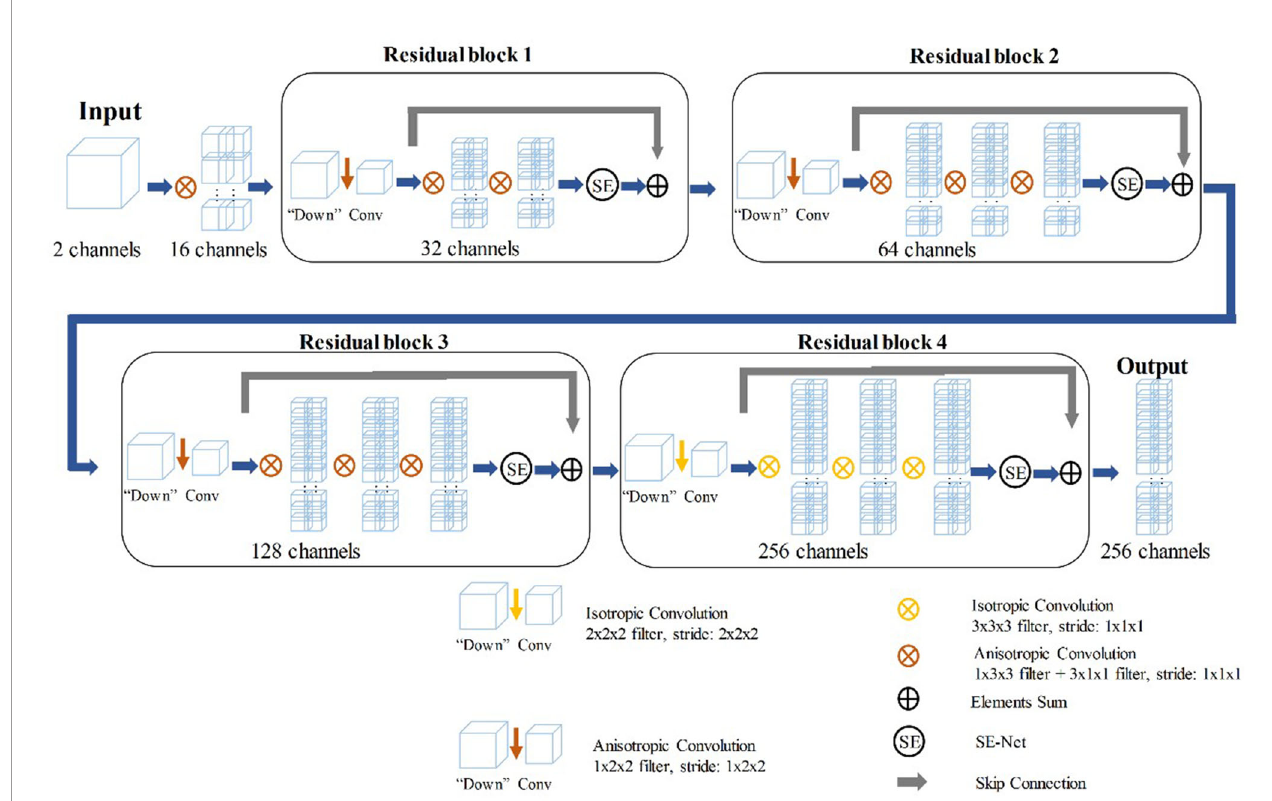
FIGURE 3 | The structure of 3D SE-Residual